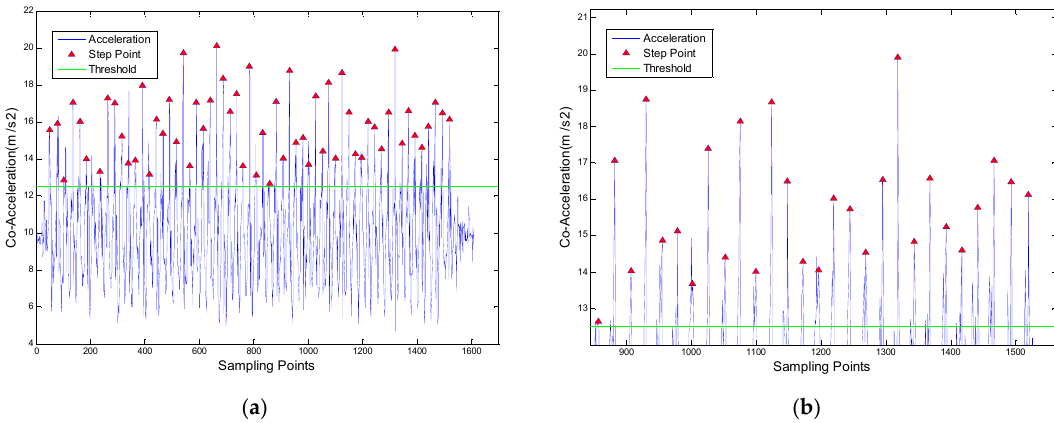
Figure 2. Experiment Results of Peak Detection Algorithm. ( a ) Overall Step Detection Results; ( b ) Step detection result of partial enlargement.